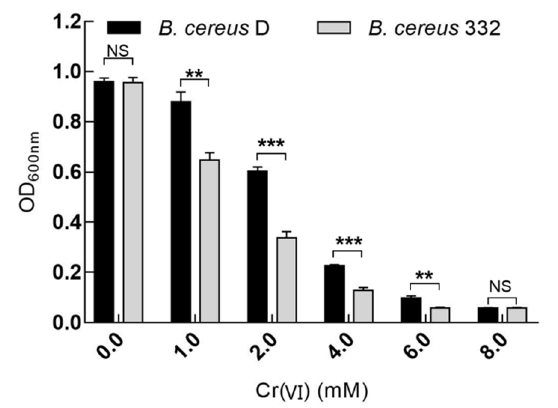
Figure 3. The effects of the concentration of Cr(VI) on the growth of B. cereus D and B. cereus 332. **** indicates p < 0.0001, *** indicates p < 0.001, ** indicates p < 0.01, and * indicates p < 0.05. NS indicates no significant difference.